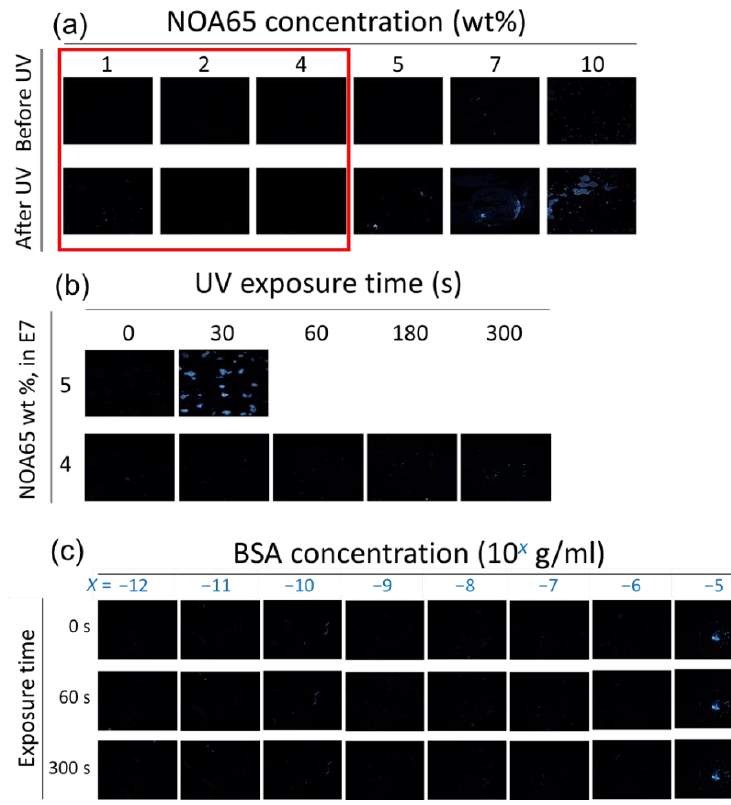
Figure 3. The optical texture of the LC–photopolymer composites at various NOA65 concentrations and UV exposure times. ( a ) E7 was doped with 1, 2, 4, 5, 7, or 10 wt.% NOA65 followed by exposure to 10-mW/cm 2 UV light for 30 s. ( b ) E7 was doped with 4 or 5 wt.% NOA65 followed by exposure to 20-mW/cm 2 UV light for 0, 30, 60, 180, or 300 s. ( c ) The optical texture of pristine E7 in the presence of immobilized BSA molecules. BSA was immobilized at concentrations ranging from 10 −12 to 10 −5 g/mL, followed by LC cell assembly and UV irradiation at 20 mW/cm 2 for 0, 60, or 300 s.